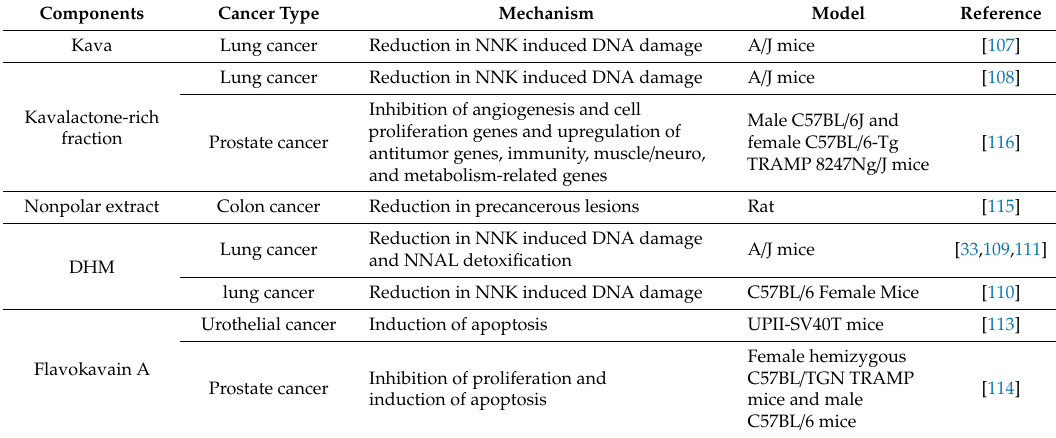
Table 5. Kava and its components in cancer